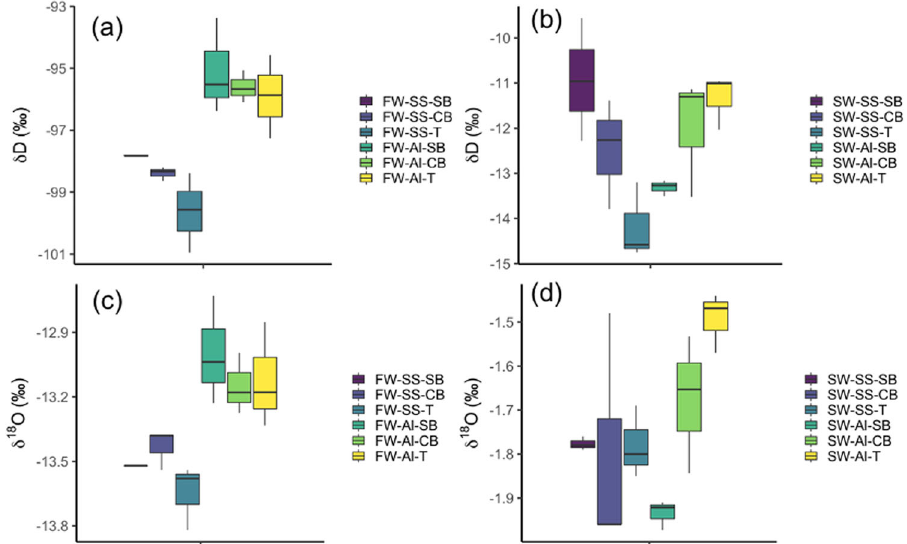
Fig. 6 Water stable isotope changes following water treatment. dD values in the a FW and b SW experiments and d 18 O values in the c FW and d SW experiments with stainless steel (SS) and aluminum (Al) electrodes. SW experiments show diverging patterns of dD and d 18 O between SS and Al electrodes. Data suggests the isotope manipulation occurs during OFF modes with CB. The box and whisker plots denote the median value (line within each box), upper and lower quartiles (top and bottom of box), and minimum and maximum values